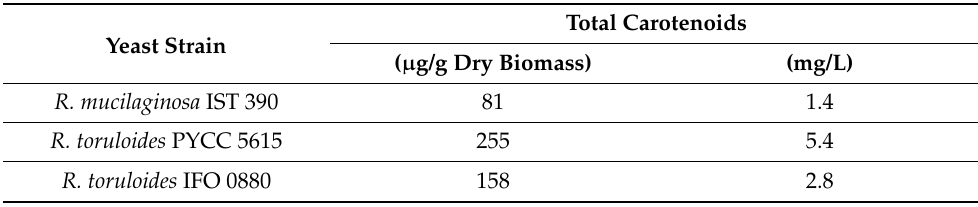
Table 2. Specific production yield of carotenoids ( µ g/g dry biomass) and volumetric carotenoid concentration (mg/L) produced by the three red yeast strains after 144 h of cultivation in sugar beet pulp hydrolysate H13, as described in the Figure 7